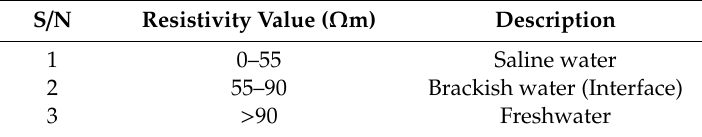
Table 3. Classification of aquifer based on resistivity value after